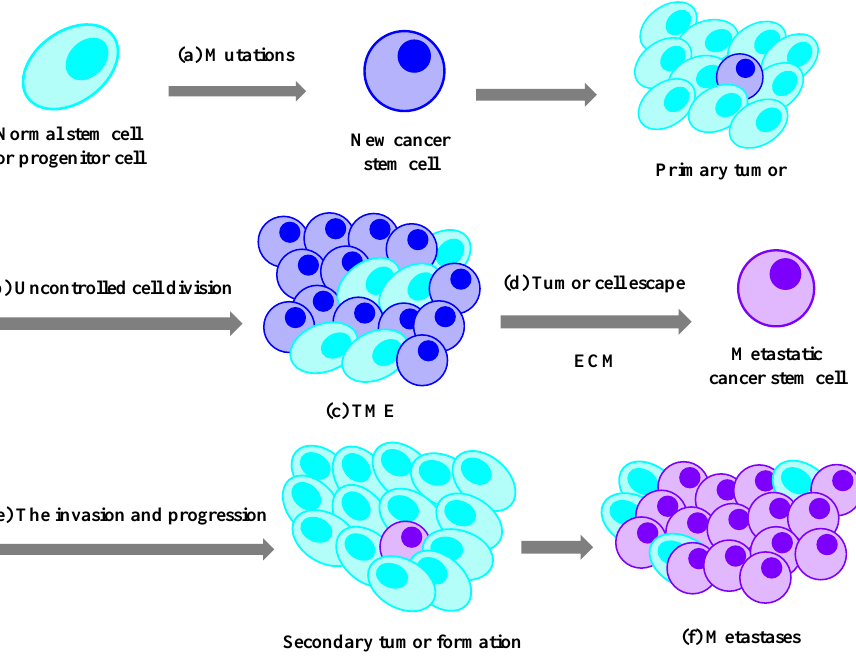
Figure 1. Main steps in the progress of cancer. ( a ) Tumorigenesis; ( b ) uncontrolled cell growth and division; ( c ) TME; ( d ) extravasation from the original tissues; ( e ) the invasion and progression; ( f ) the creation of cancer cell niches (metastasis).